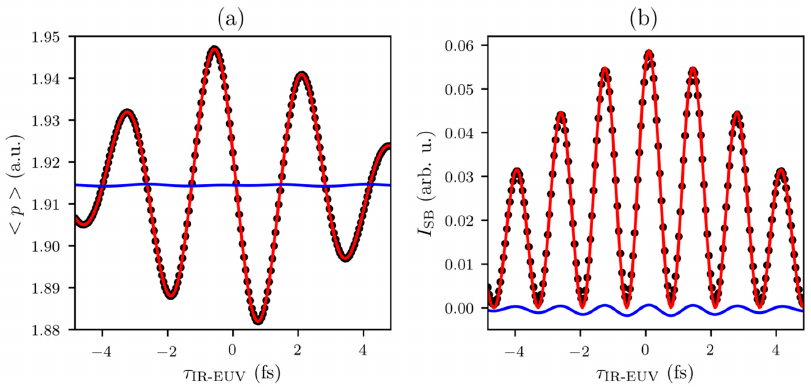
Figure A1. Analysis of simulated photoelectron spectra for a 50 eV photoelectron interacting with an IR pulse with a center wavelength of 800 nm, pulse duration of 5 fs, and maximum electric field amplitude E 0 = 1